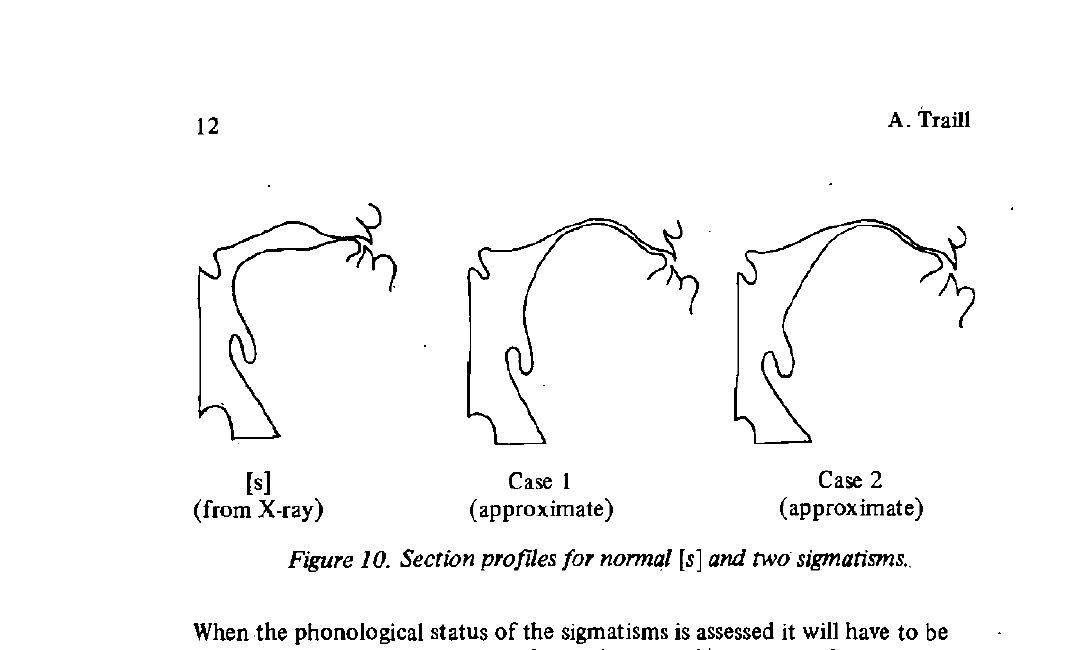
Figure 10. Section profiles for normal [s] and two